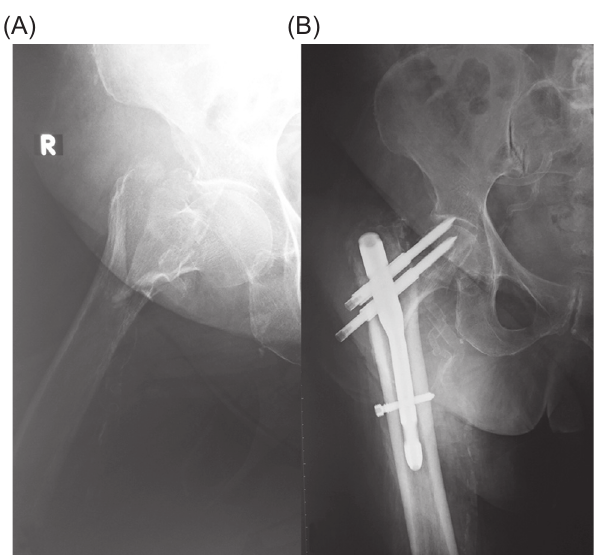
Figure 4. (A) Anteroposterior radiograph of the right hip of an 85-year-old woman shows an AO/OTA-31-A2 fracture. (B) Antero- posterior radiograph of the right hip eight weeks after surgical treatment shows screw cut-out and z-effect. The patient was alive with poor function and did not consent to further